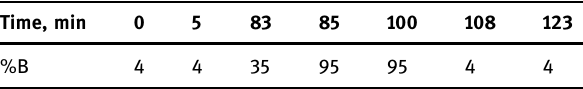
Table 1: Gradient pro fi le used for peptide C 18 separation Time,